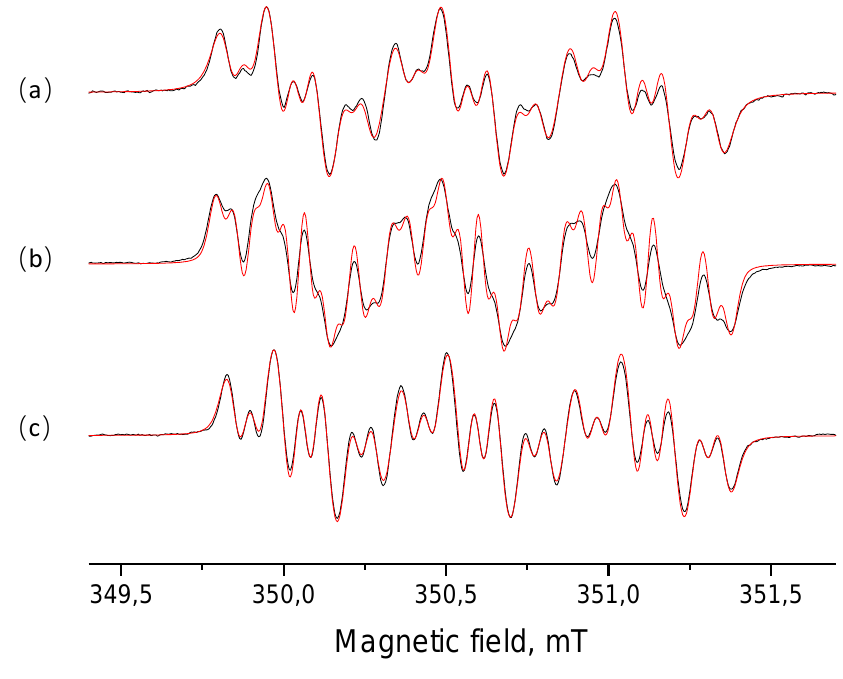
Figure 3. EPR spectra acquired for diluted and oxygen-free toluene solutions of HPNs at 295 K: ( a ) 22e , ( b ) 22j , and ( c ) 22o . Table 3. EPR parameters used for 22a–o spectral simulations. [R 2h ] / [R o ]: a relative proportion of HPNs that survived after keeping the solution of the radical for 2 h in an argon